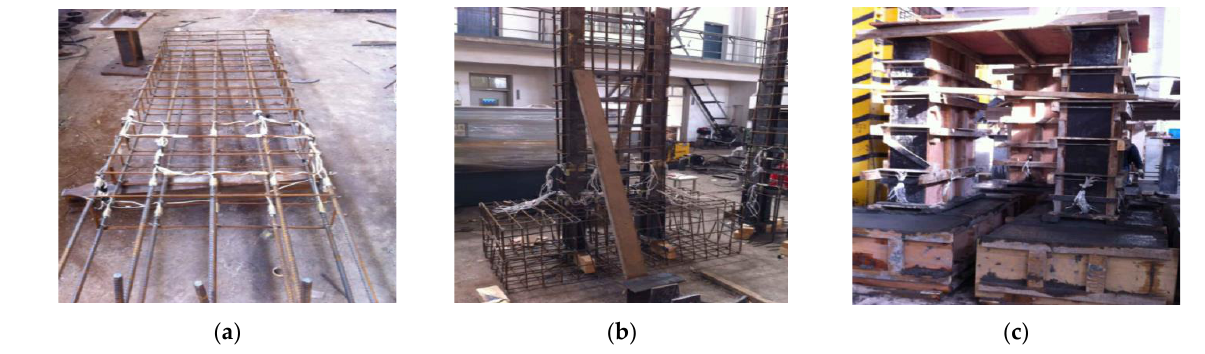
Figure 2. The Manufacturing Process of the Test Specimens. ( a ) Reinforcement skeleton. ( b ) H-shape steel. ( c ) Pouring of concrete.